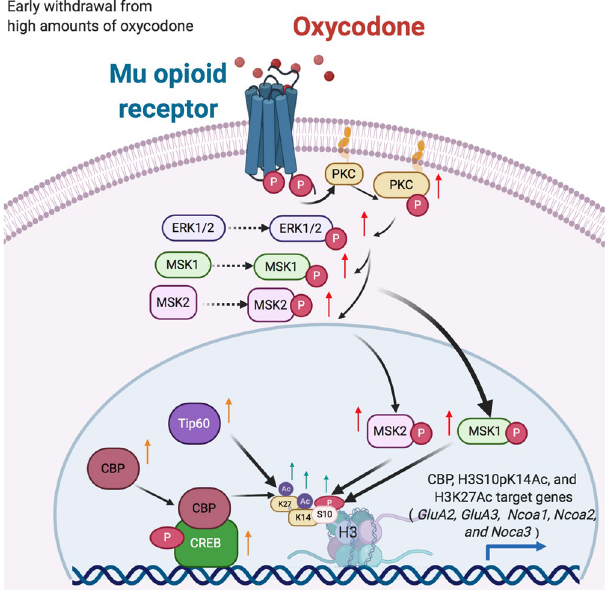
Figure 9. Illustration of the activation of MAPK/MSK signaling pathway in LgA-H rats. Intake of large amount of oxycodone during long-access over 20 days caused increased phosphorylation of PKC, ERK1/2, MSK1, and MSK2. Increased MSK phosphorylation is accompanied by increased histone H3 phosphoacetylation and CREB phosphorylation. In addition, there were increases in the protein expression of two acetyltransferases, CBP and Tip60 that acetylate H3K27. Recruitment of CBP by CREB and histone modifications serve to create a permissible transcriptional environment that led to increased mRNA levels of GluA2 and GluA3 in a MSK1- dependent fashion. This kinase-histone modification cascade may serve as targets for therapeutic interventions against oxycodone use